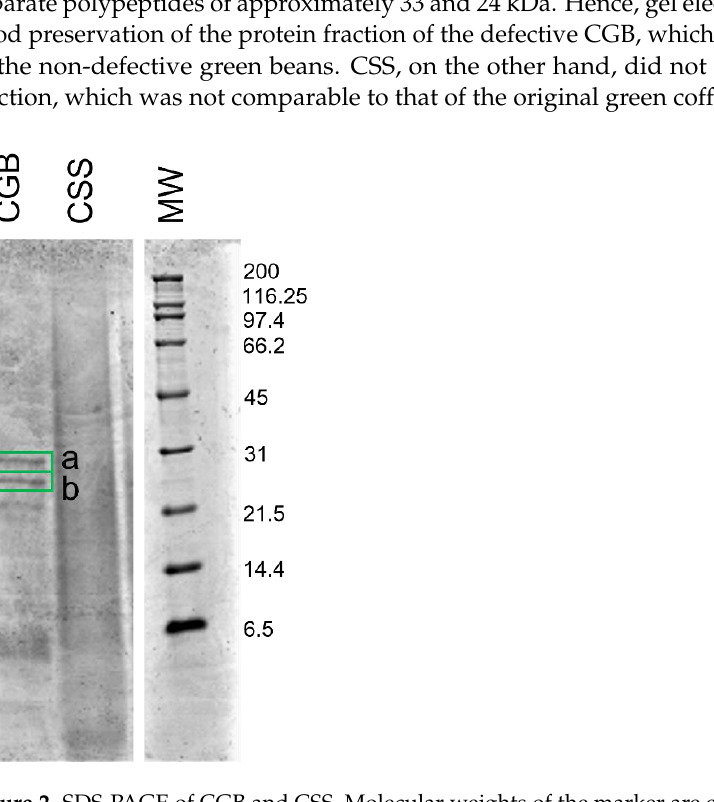
Figure 2. SDS-PAGE of CGB and CSS. Molecular weights of the marker are expressed in kDa. Bands identified by HRMS are